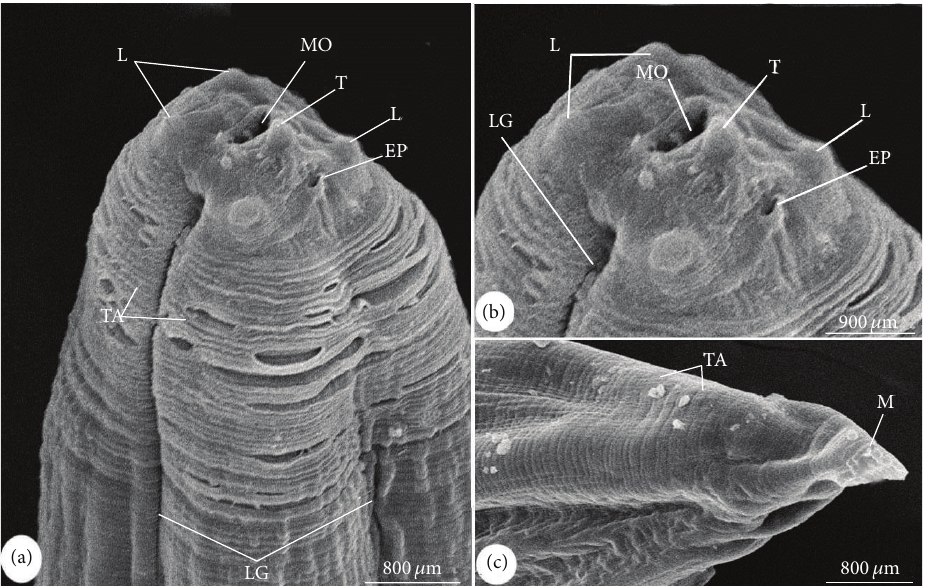
Figure 2: Scanning electron micrographs of A. simplex (L3). (a) The anterior part showing a boring tooth (T), labia papillae (L), mouth opening (MO), excretory pore (EP), longitudinal lateral groove (LG), and transverse annulations of cuticle (TA). (b), (c) High magnifications of (b) top view of the anterior part. (c) Posterior extremity with mucron (M).